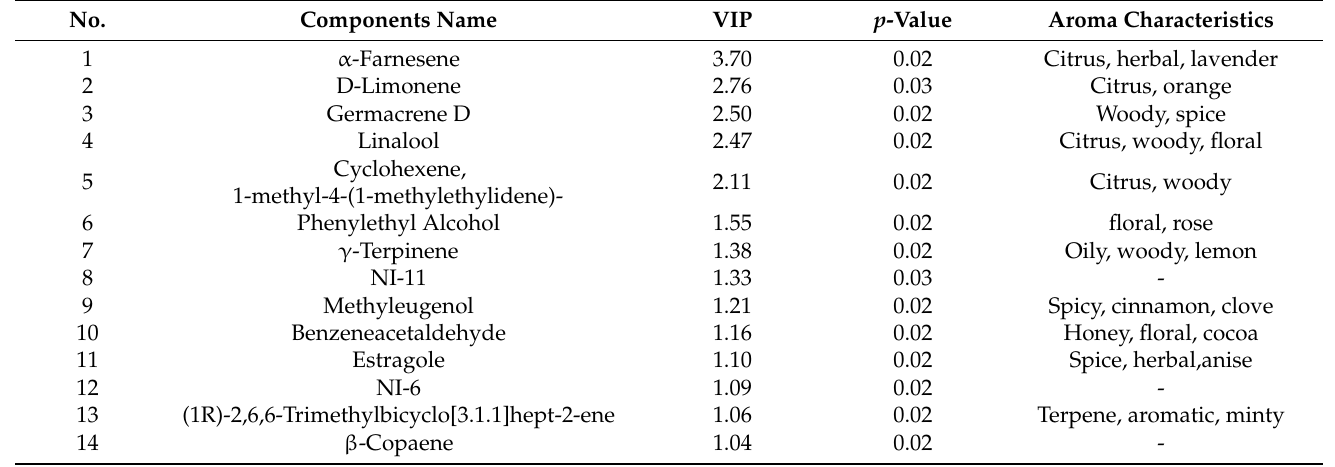
Figure 4. Permutation test of PLS-DA model. ( a ) T. cordata ; ( b ) T. miqueliana ; ( c ) T. tomentosa . Table 3. Characteristics of the 14 crucial components in the PLS-DA model.